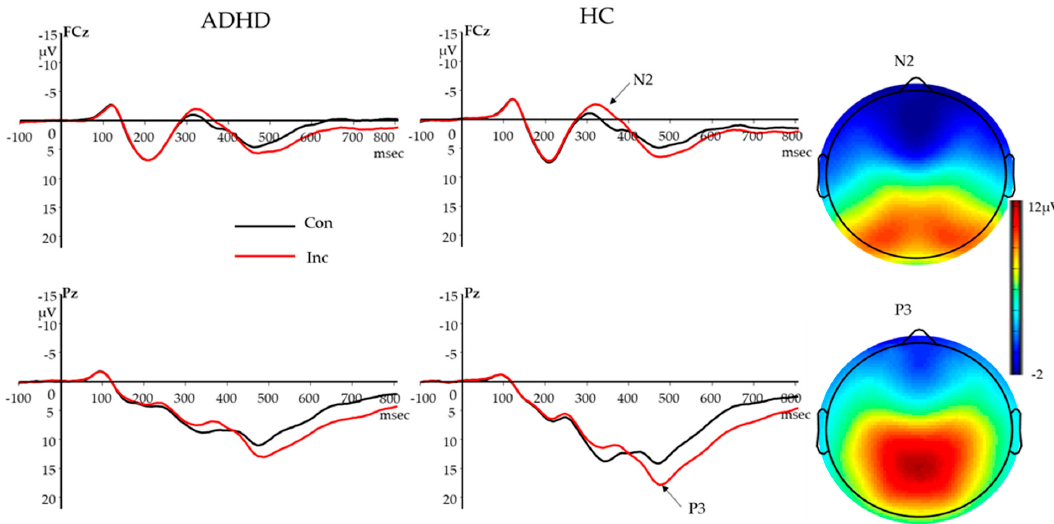
Figure 2. N2 and P3 waveforms for participants with ADHD and HC, and topography for